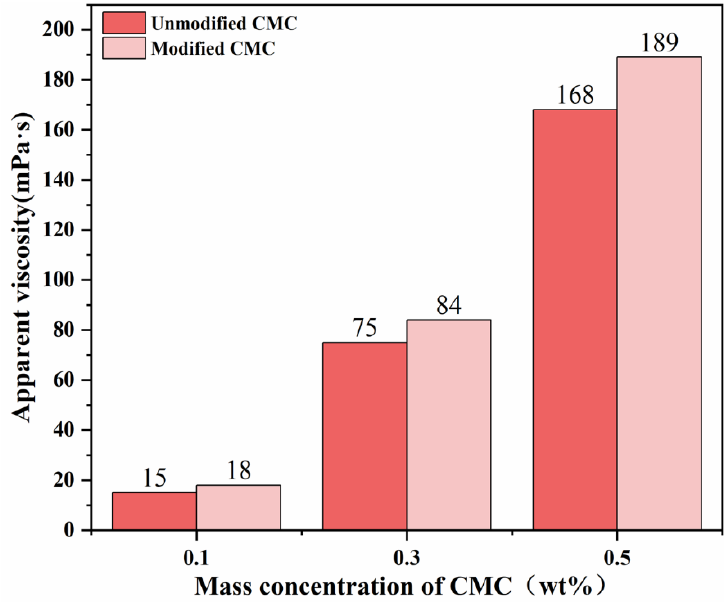
Figure 12. Comparison of apparent viscosity between modified CMC and unmodified CMC in pure water.